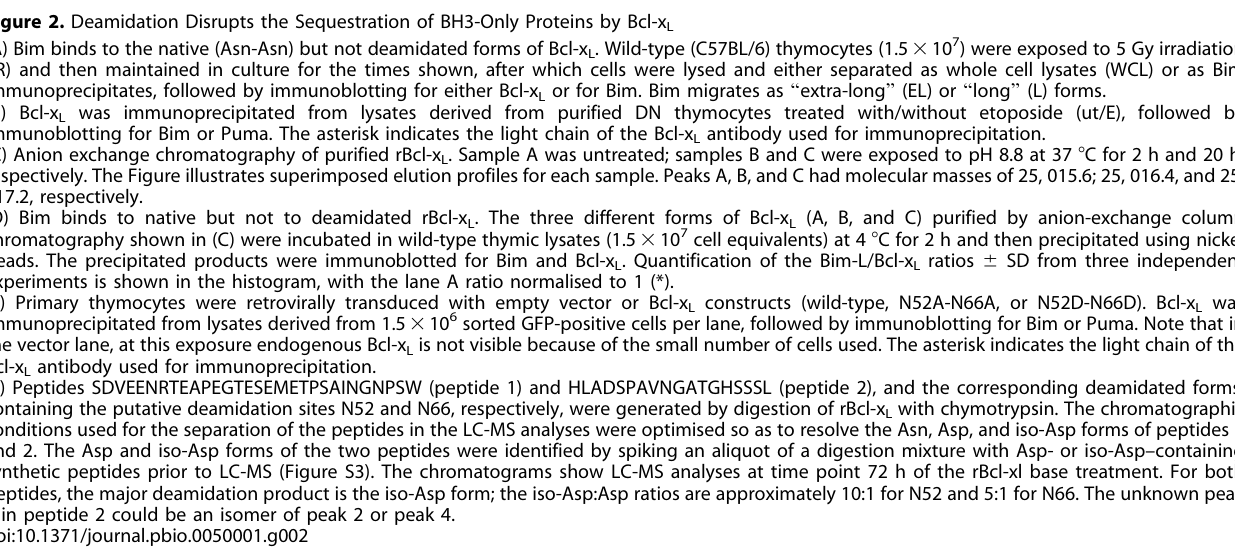
tion of Asn 66 to iso-Asp is much faster than for Asn 52 (unpublished data).